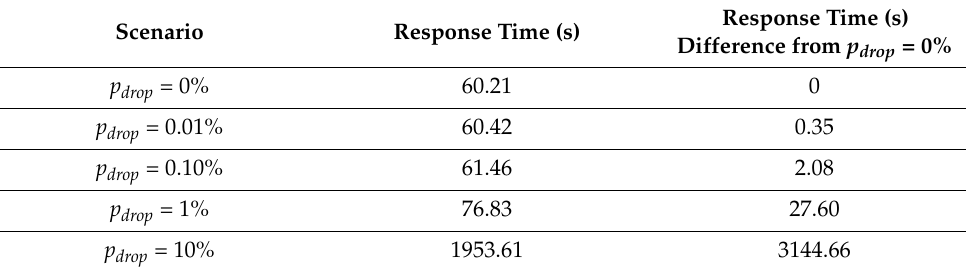
Table 4. FTP Download Response Time for Five Selected Scenarios.